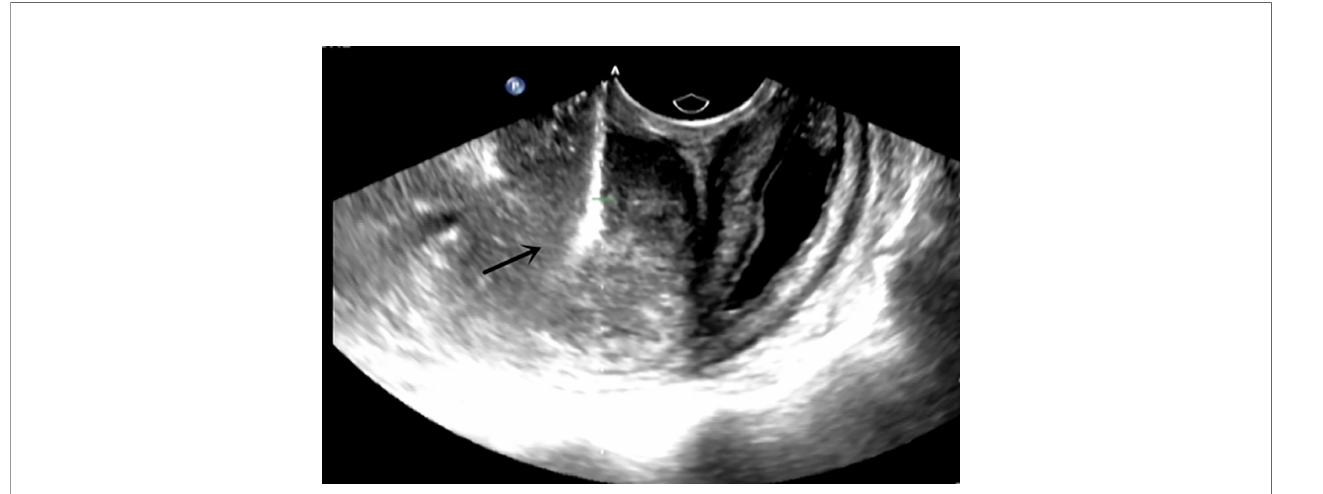
FIGURE 3 | Ultrasound guided transvaginal pelvic mass